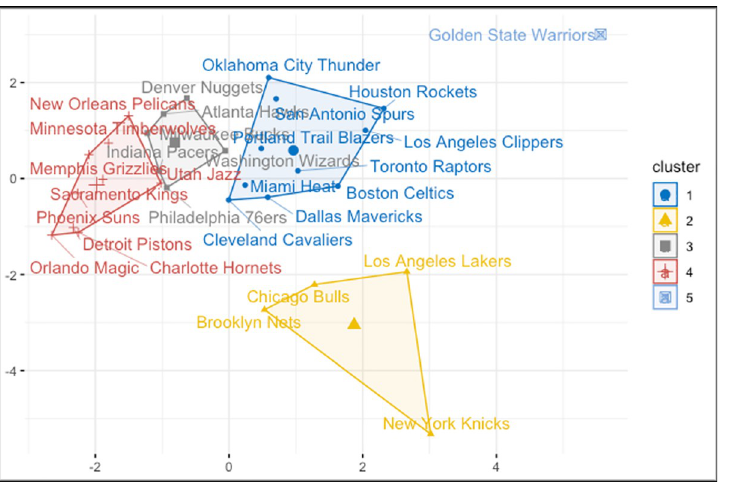
Fig 6. K-means clustering